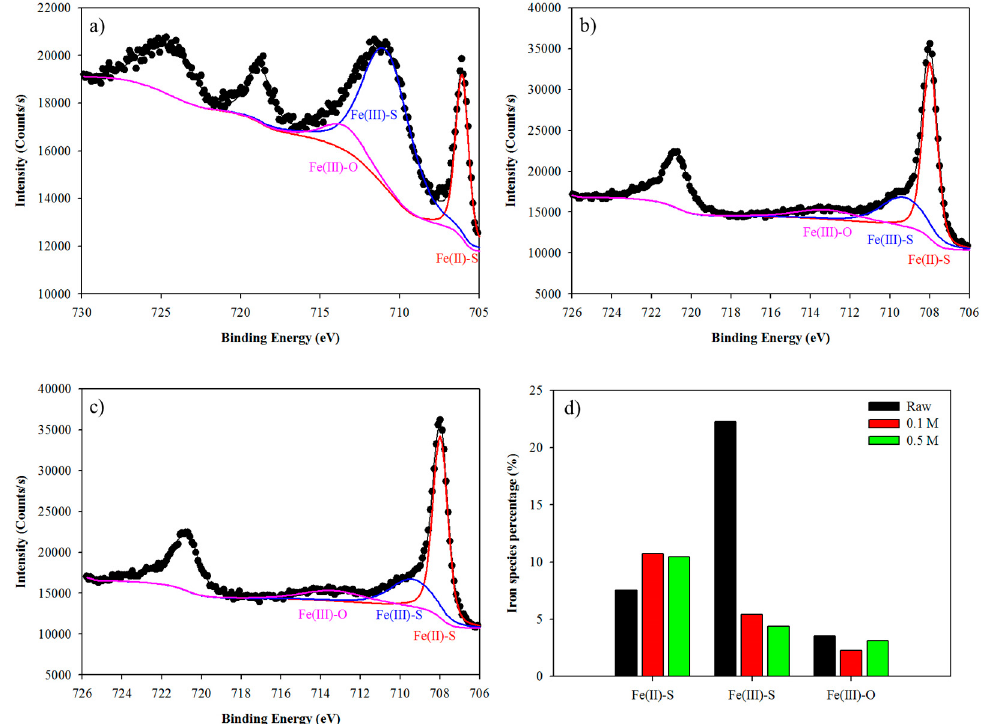
Figure 9. XPS spectra of Fe2p for ( a ) raw concentrate, ( b ) leach residue (0.1 M), ( c ) leach residue (0.5 M), and ( d ) distribution of the surface Fe species. The leaching conditions were 80 °C and 15 min.